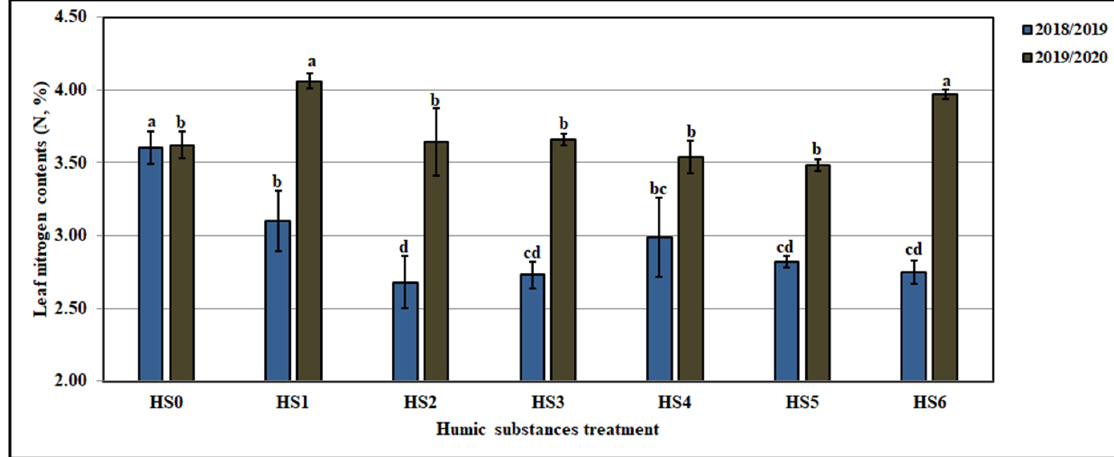
Figure 19. Influence of humic substances treatments on leaf nitrogen contents (N, %) of some wheat varieties grown in clay loam soil in 2018/2019 and 2019/2020 seasons. Bars in the same years with a different letter indicate significant differences between treatments at p ≤ 0.01. HS 1, HS 2 , HS 3 represent HS applied as foliar spray at 1.0, 2.0, 4.0 g L − 1 , respectively, HS 4 , HS 5 , HS 6 represent HS applied as soil application at 5.04, 7.56, 10.08 kg ha − 1